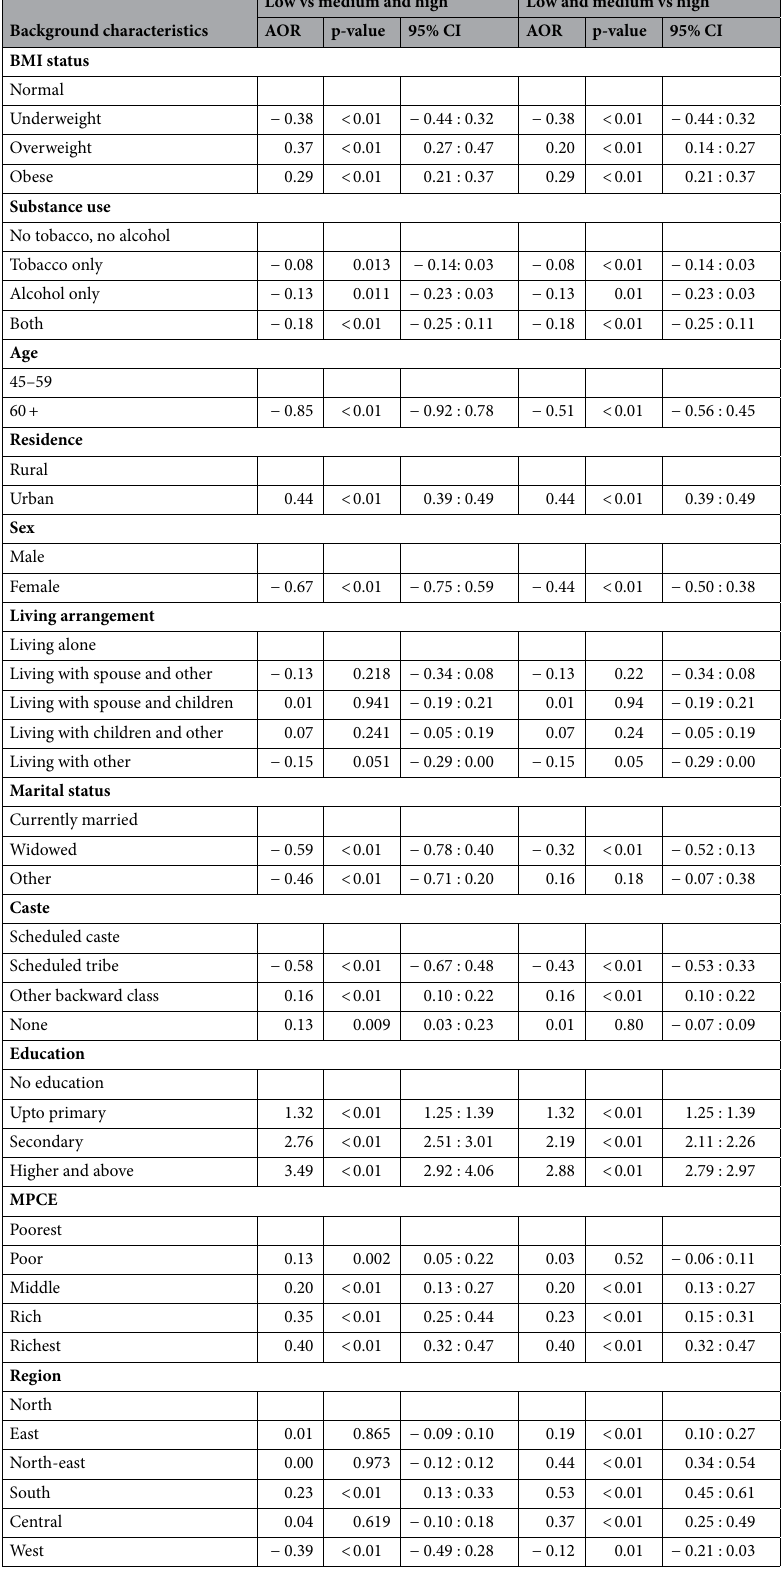
Table 3. Partial proportional odds model estimation of cognition score of older adults aged 45 and above, India, LASI Wave 1,